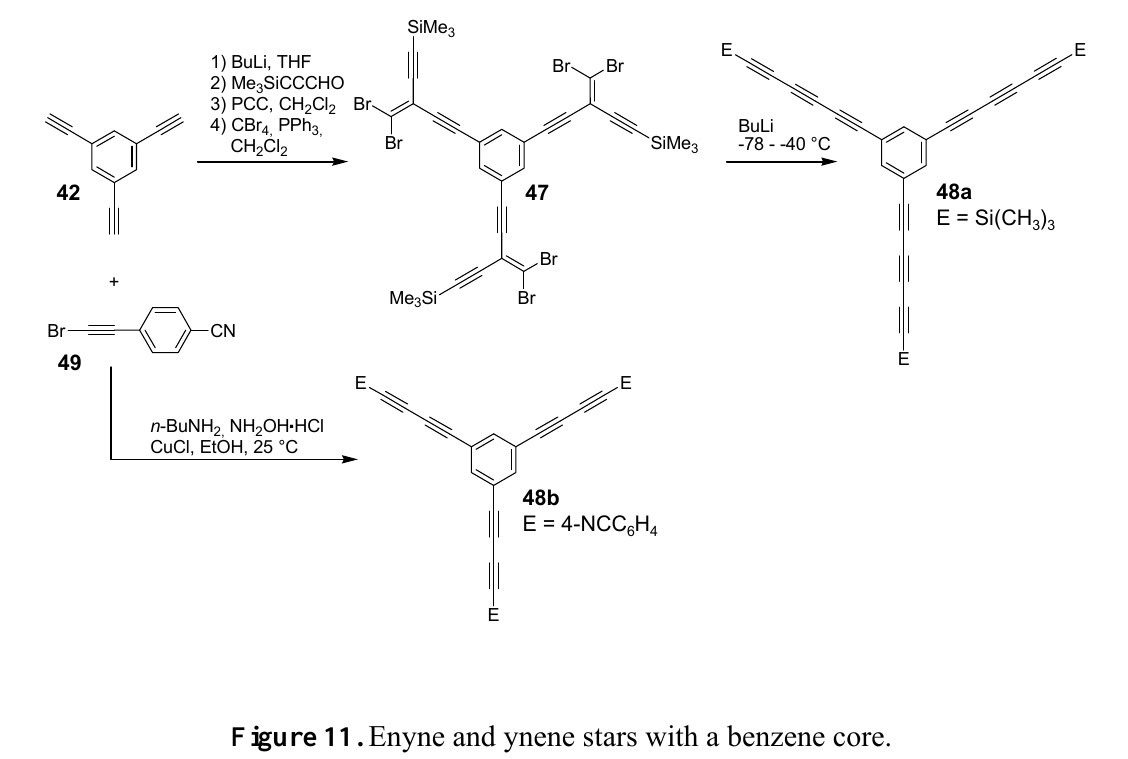
Figure 11. Enyne and ynene stars with a benzene